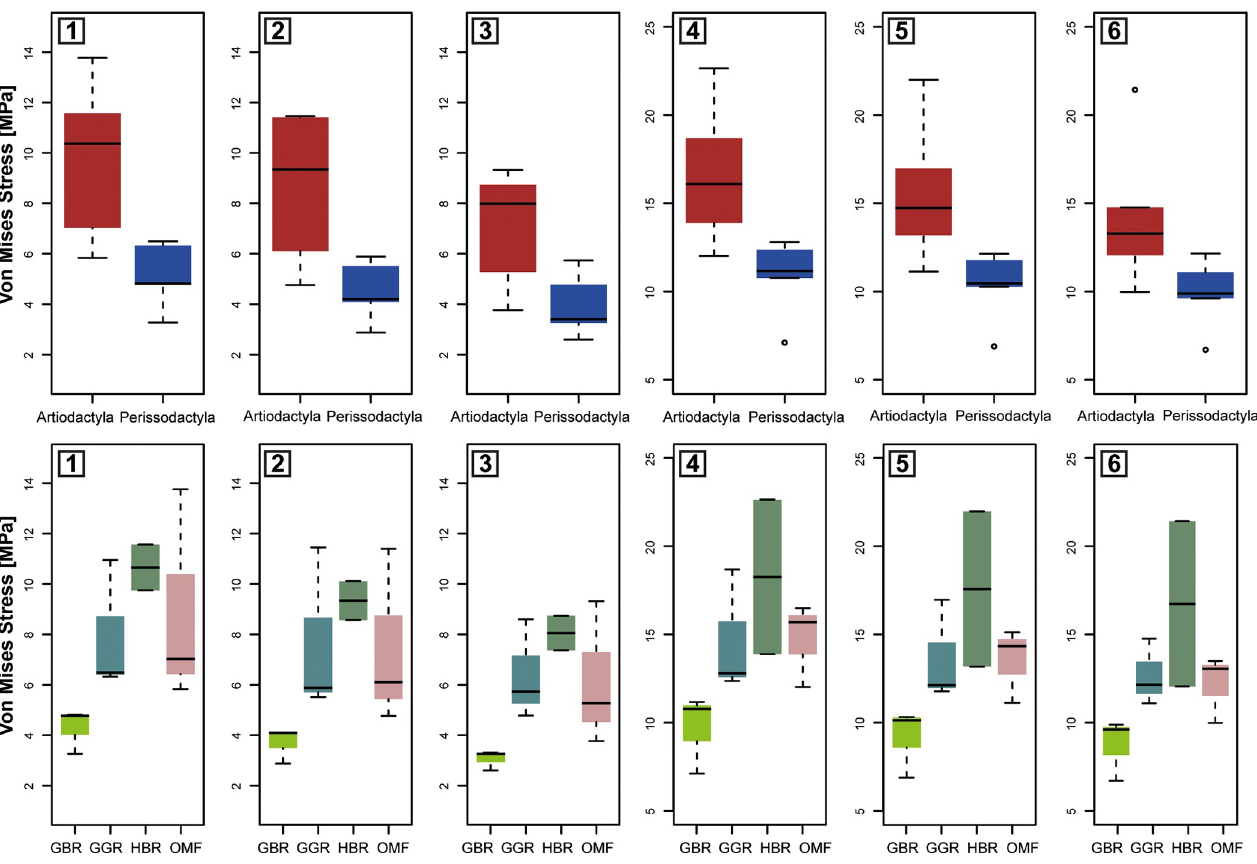
Fig 5. Boxplots of the peak stress values (assuming the 95 th percentile as the peak stress value) for all species grouped by order (Artiodactyla and Perissodactyla) and by dietary categories (GGR: General grazer, GBR: General browser, OMF: Open-habitat mixed-feeder and HBR: High-level browser). Lateral cases 1) in M1 2) in M2 and 3) in M3. Orthal cases 4) in M1 5) in M2 and 6) in M3. Central line is the median, whiskers represent the range.